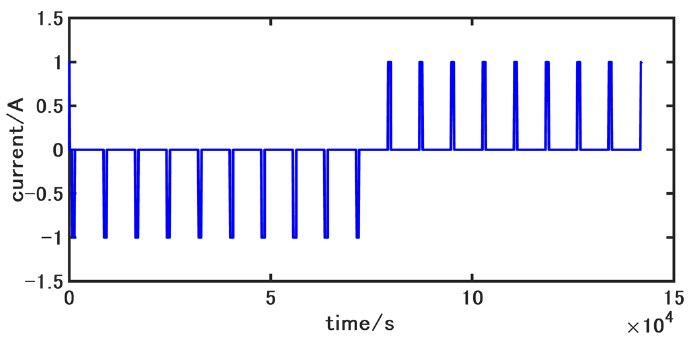
Figure 2. Current of Incremental Current Condition.